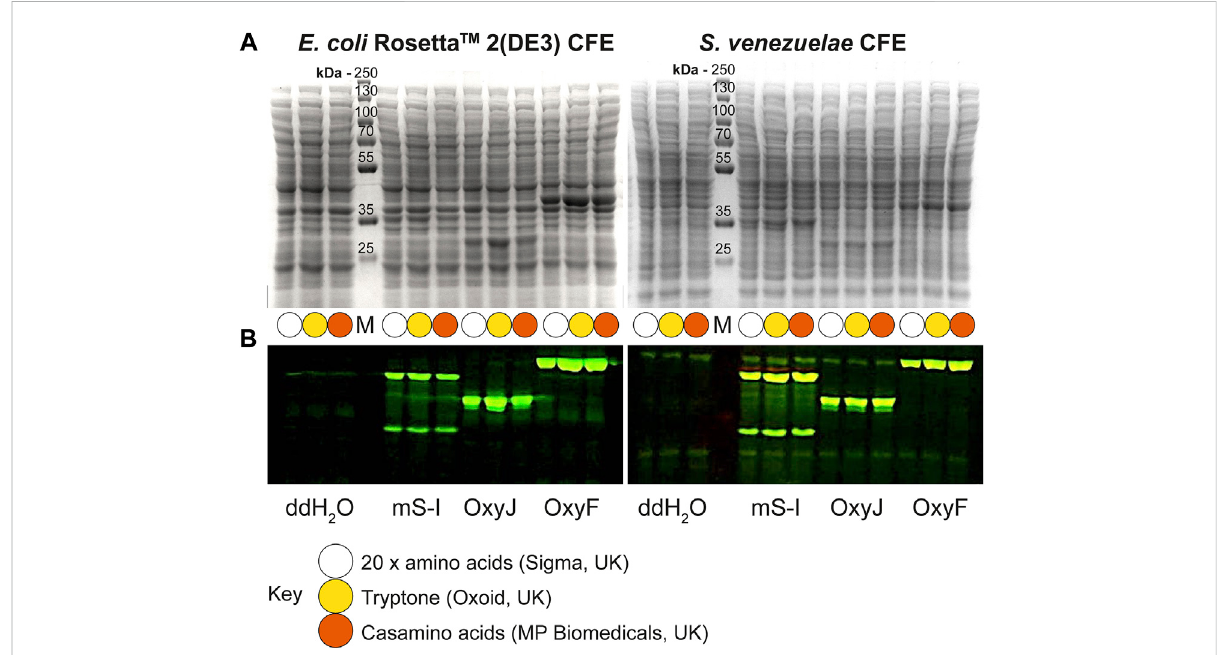
FIGURE 3 DenaturingPAGEanalysisof E.coli Rosetta ™ 2(DE3)and S.venezuelae CFEreactionsmakingmScarlet-I,OxyJandOxyFproteinsusingdifferent AA sources. (A) Coomassie blue staining and (B) In-gel fl uorescence stain of C-terminal tetracysteinetaggedproteins. The best-performing batches for tryptone (Batch B) and casamino acids (Batch A) at 1.6% (w/v) were used to compare with the standard AAs source. Abbreviations: